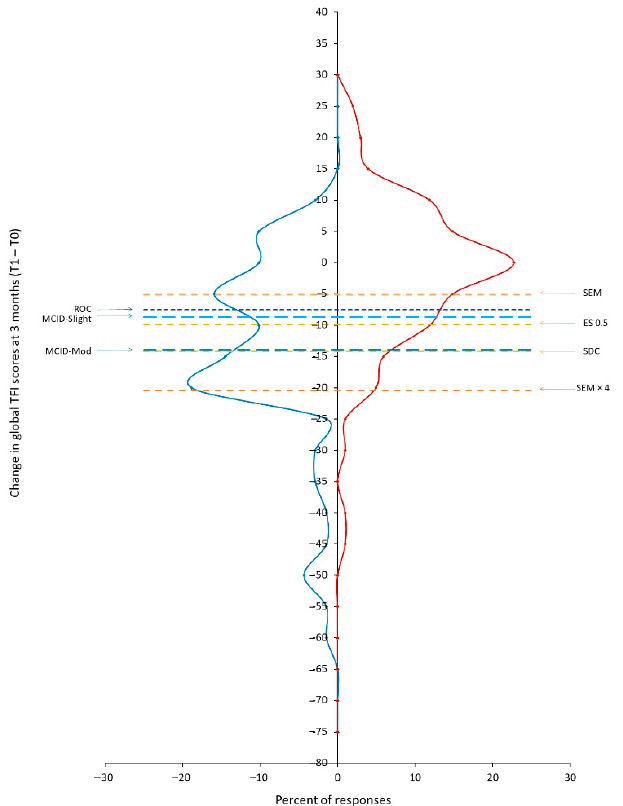
Figure 3. Distributions (expressed in percentages) of the changes in TFI global scores for tinnitus patients who reported improvements in tinnitus (blue distribution line) and those who reported no change in tinnitus at 3 months from baseline (red distribution line). SEM = Standard Error of Measurement, SEM × 4 = Standard Error of Measurement multiplied by 4, ROC = Receiver Operating Characteristic (ROC) optimal value, SDC = Smallest Detectable Change, MCID-Slight = Minimal Clinically Important Difference estimates for ‘slightly improved’, MCID-Mod = Minimal Clinically Important Difference estimates for ‘moderately